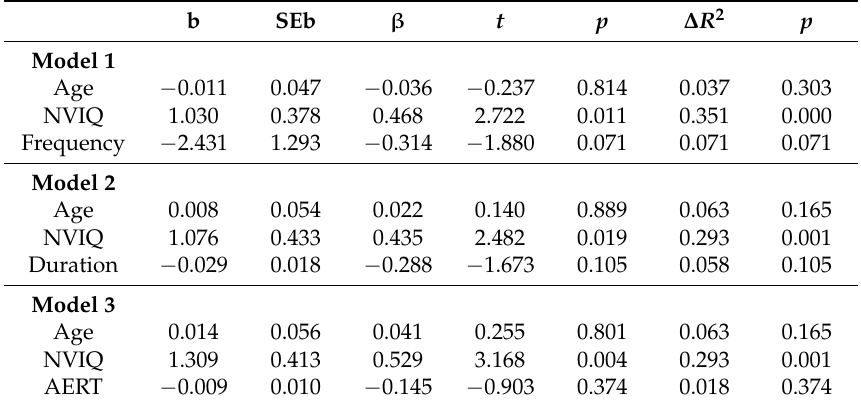
Table 7. Stepwise regressions showing the unique variance in children’s accuracy in judging metrical and syntactic boundaries contributed by the different auditory processing measures.